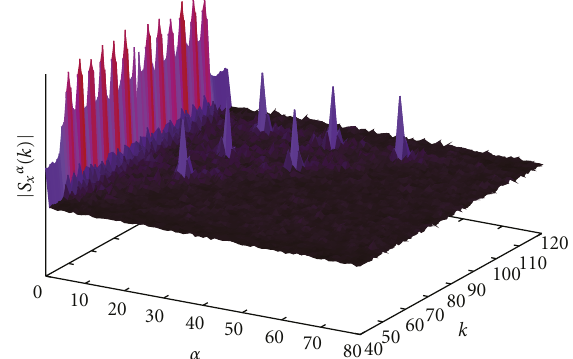
Figure 3: SCF estimation for an IEEE 802.11a signal with L = 500 and E b /N 0 = 0dB.